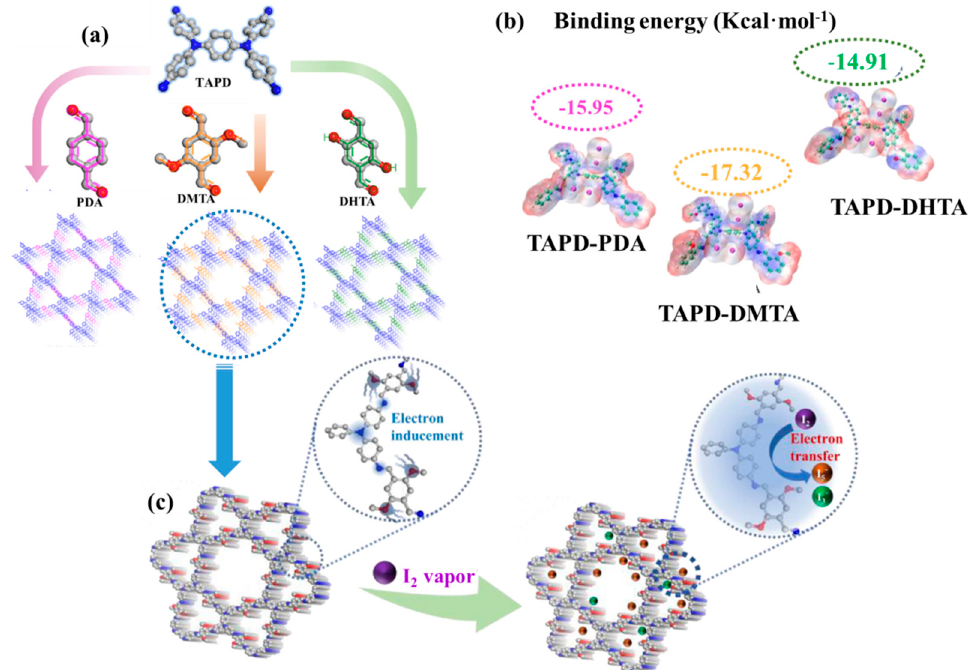
Figure 12. ( a ) Schematic diagram of the COF synthesis. ( b ) Schematic illustration of the iodine uptake mechanism of TAPD − DMTA COF. ( c ) The binding energy with iodine and ESP analysis. Reprinted/adapted with permission from Ref. [70]. Copyright (2022), Elsevier.